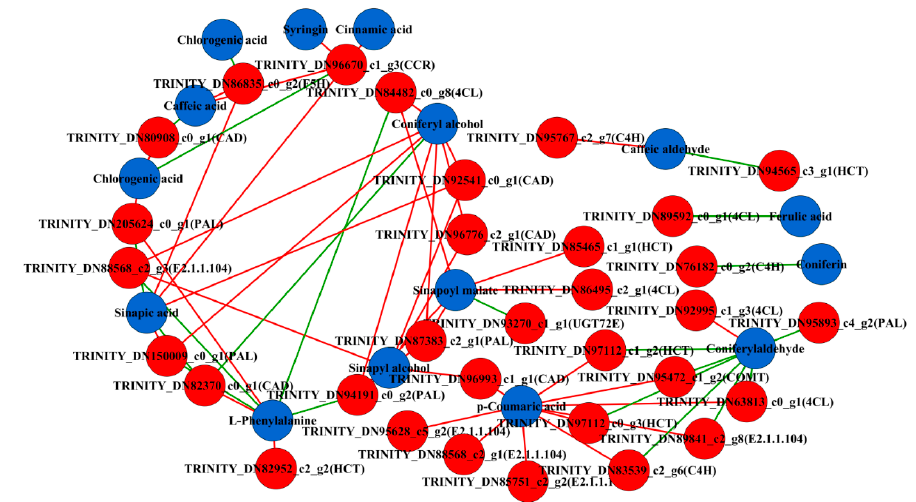
Figure 3. Co-expression analysis of structural genes and metabolites of phenolic acid biosynthesis pathway in the leaves of Cyclocarya paliurus at different developmental stages. Blue nodes represent metabolites and red nodes represent genes. Red edges represent positive correlations and green edges represent negative correlations.